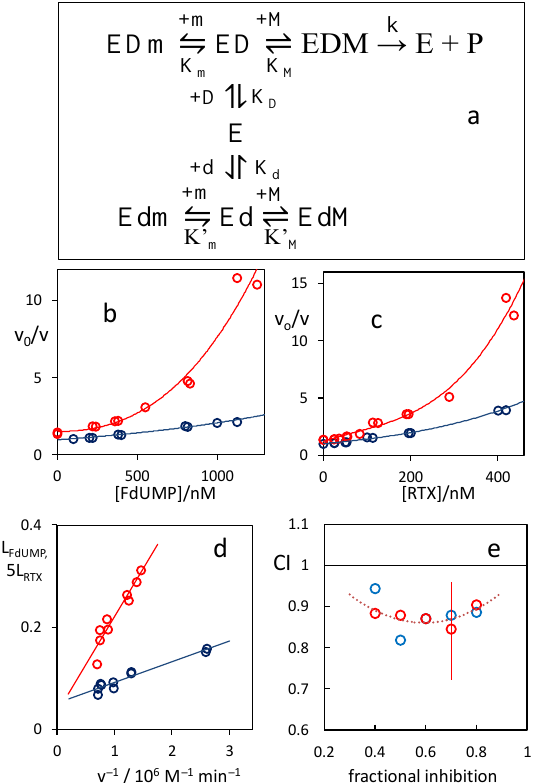
Figure 4. ( a ) Kinetic scheme for the inhibition of hTS (E) by FdUMP ( d ) and RTX (m); D represents the dUMP substrate, M the mTHF cofactor; ( b , c ) blue symbols: single-inhibitor Dixon-type plots for FdUMP ( b ) and RTX ( c ) alone; red symbols: Dixon-type plots for the inhibition by combinations of FdUMP with RTX 120 nM ( b ) and of RTX with FdUMP 450 nM ( c ). v o (rate without inhibitors) = 16 μM min −1 . The curves only represent exponential-function fittings of the data. ( d ) Tight-binding analysis of the single-compound inhibition data of hTS by FdUMP (red symbols, L FdUMP ) and RTX (blue symbols, 5 L RTX ). v is the reaction rate, L FdUMP and L RTX are the left members in eqs. S1 and S2 in the Supplementary Information. The values of L FdUMP reported in the plot were calculated assuming K M ’ = 5 K M . ( e ) Isobologram showing the combination indexes (CI, see the text) for RTX/FdUMP combinations giving the fractional inhibitions (fi = 1 − v/v 0 ) reported. Blue circles: [FdUMP] = 450 nM, [RTX]/nM = 55 (fi = 0.4), 70 (fi = 0.5), 120 (fi = 0.6), 180 (fi = 0.7), 260 (fi = 0.8); red circles: [RTX] = 120 nM, [FdUMP]/nM = 100 (fi = 0.4), 300 (fi = 0.5), 450 (fi = 0.6), 650 (fi = 0.7), 1000 (fi = 0.8). The curve is just a quadratic-function fitting to the CI/fract.inhib. data points. A typical estimated error bar is